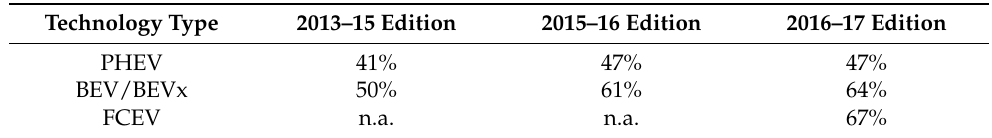
Table A3. Weighted Rebate Essentiality by Survey Edition and Technology